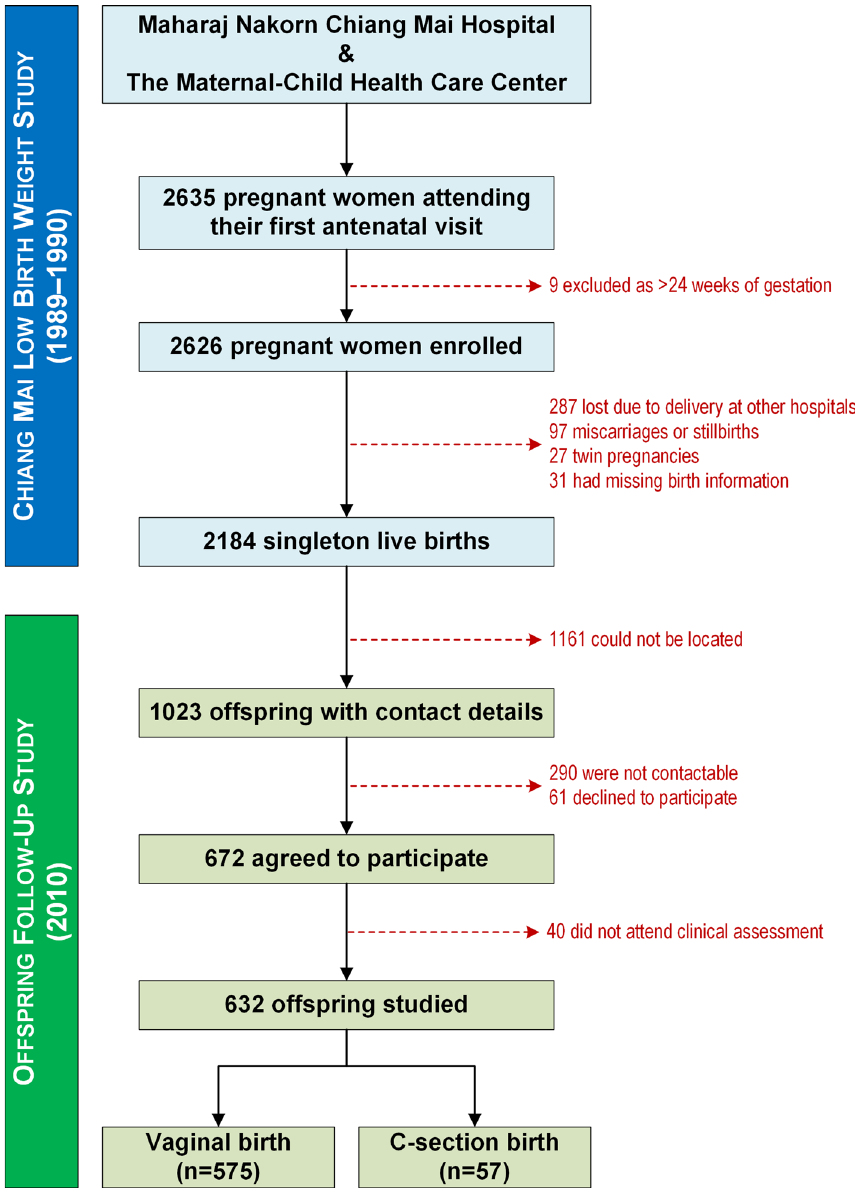
Figure 1. Flow diagram outlining participants’ recruitment into the Chiang Mai Low Birth Weight Study (1989–1990) and subsequently to the follow-up study on the offspring